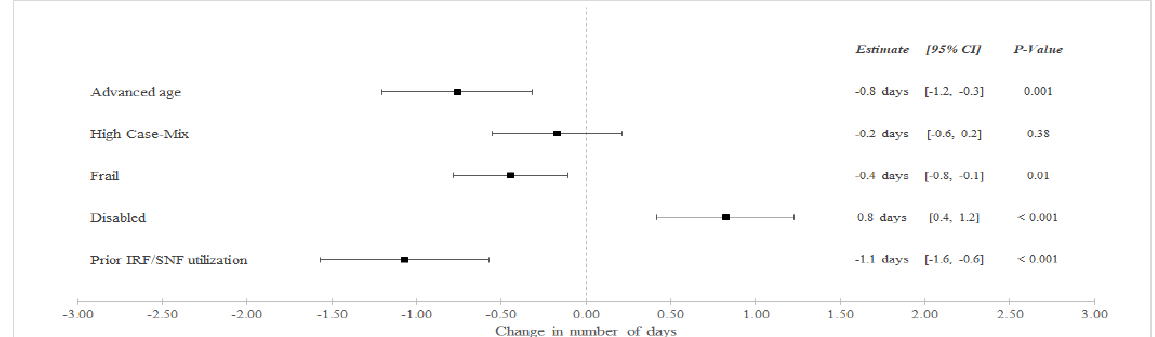
Figure 1. Adjusted Changes in in SNF LOS for Medical Condition Episodes Among High-Risk Patients (2011–2016). Abbreviations: LOS = length of stay; IRF = Inpatient Rehabilitation Facility; SNF = Skilled Nursing Facility. Advanced age = Age > 85 years old. High Case-Mix = Top 20% of Elixhauser score. Prior IRF/SNF Utilization = Utilization within the preceding 12 months.